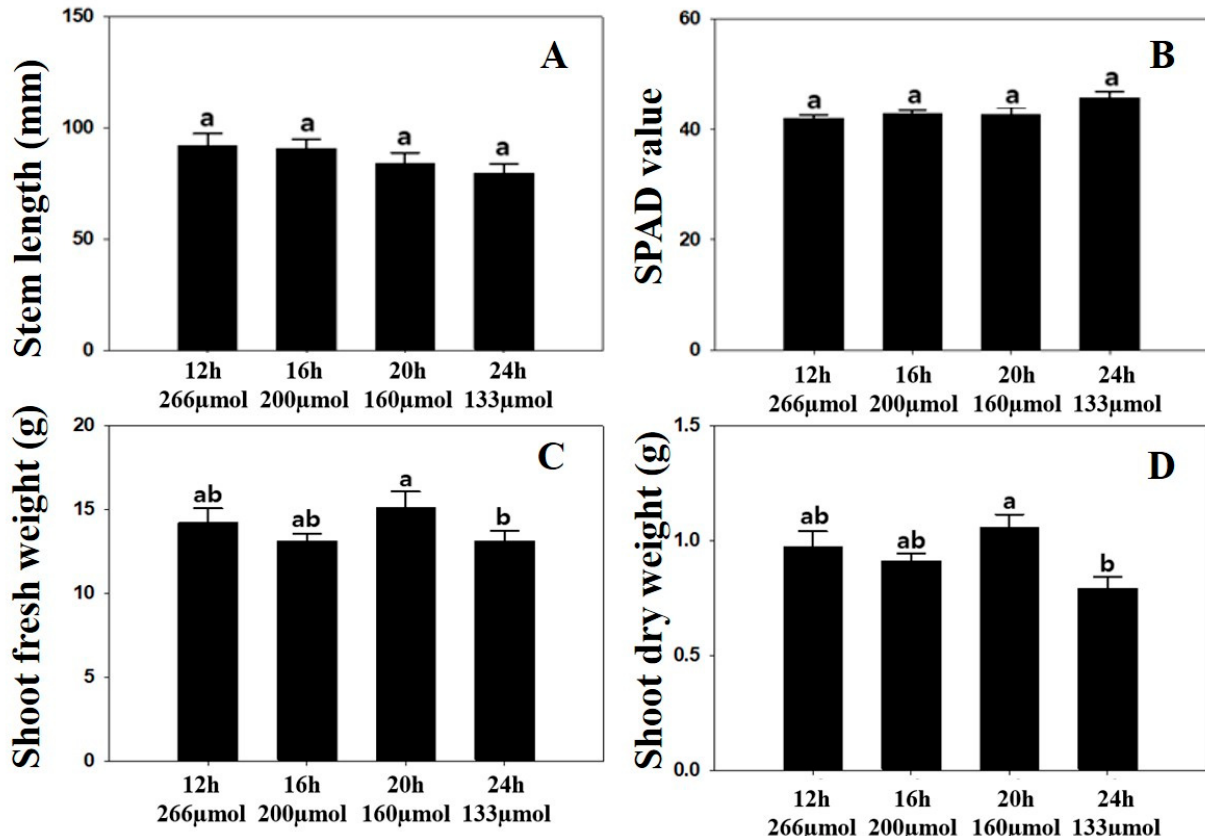
Figure 1. Stem length ( A ), SPAD value ( B ), shoot fresh weight ( C ), and shoot dry weight ( D ) under different lighting treatments of 12 h—266 µmol . m − 2. s − 1 , 16 h—200 µmol . m − 2. s − 1 , 20 h—160 µmol . m − 2. s − 1 , and 24 h—133 µmol . m − 2. s − 1 . Different letters above bars show significant differences at p ≤ 0.05, using Tukey’s multiple range test ( n = 6). The net photosynthesis and stomatal conductance were reduced with increasing photoperiod and decreasing light intensity (Figure 2). Specifically, the net